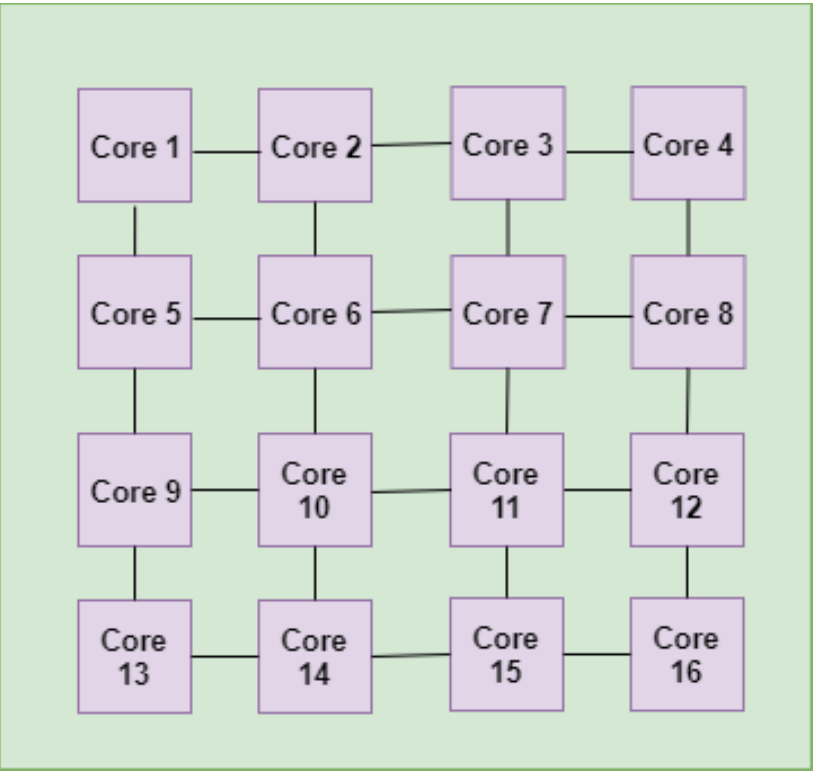
Figure 2. A 16 × 16 NoC